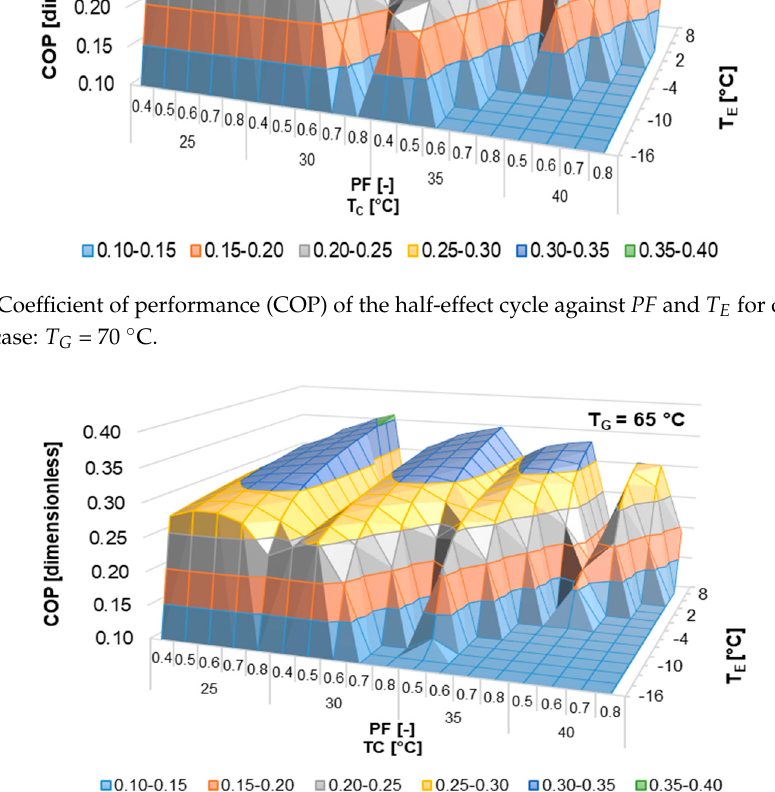
Figure 11. COP of the half-effect cycle against PF and T E for different T C . Analyzed case: T G = 65 °C.